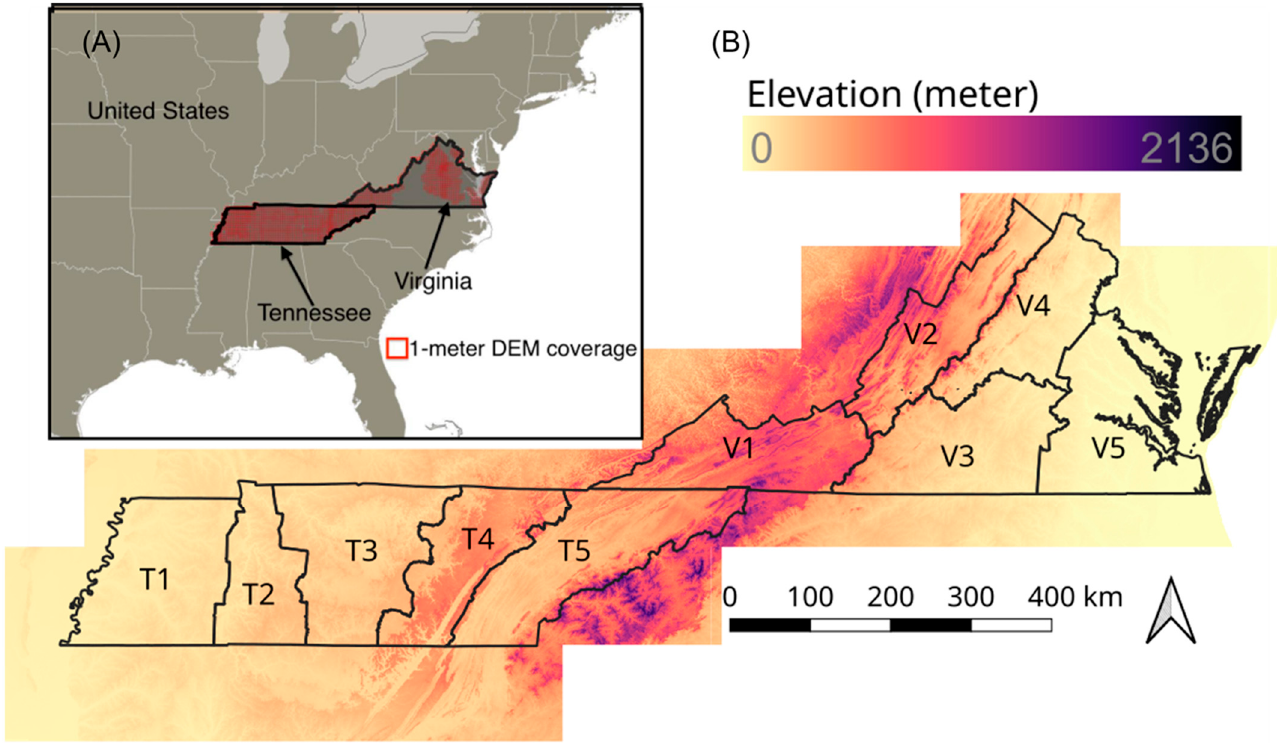
Figure 2. Study area showing ( A ) the states of Tennessee (TN) and Virginia (VA) with red outline indicating the 1 m DEM coverage and ( B ) the elevation and survey units in each state. Combinations of letters and numbers represent survey units. T1: West, T2: West Central, T3: Central, T4: Plateau, T5: East, V1: Coastal Plain, V2: Southern Piedmont, V3: Northern Piedmont, V4: Northern Moun-